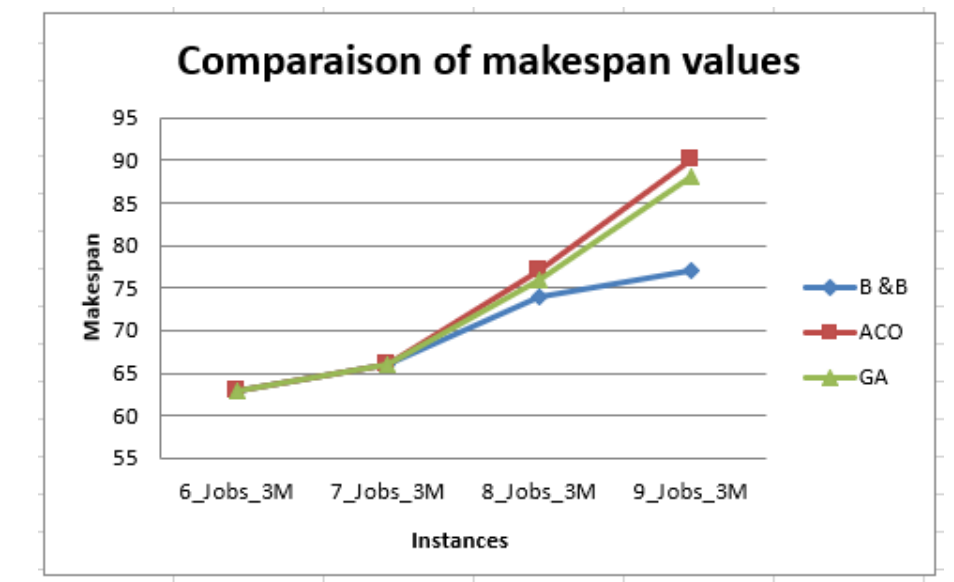
Figure 12. Comparison of the makespan